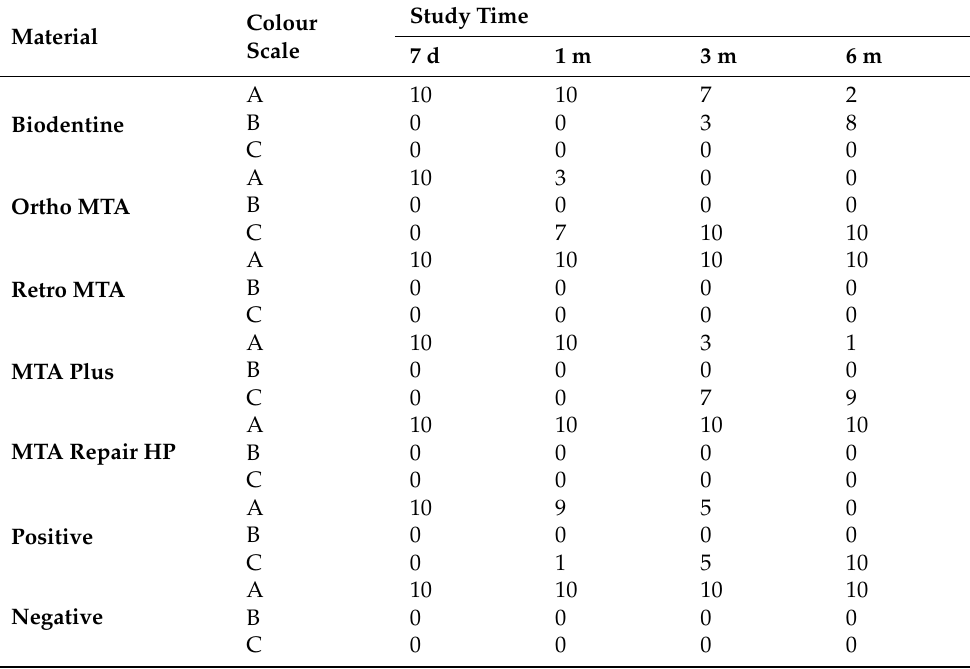
Table 3. Clinical evaluation of the changes in teeth colour.